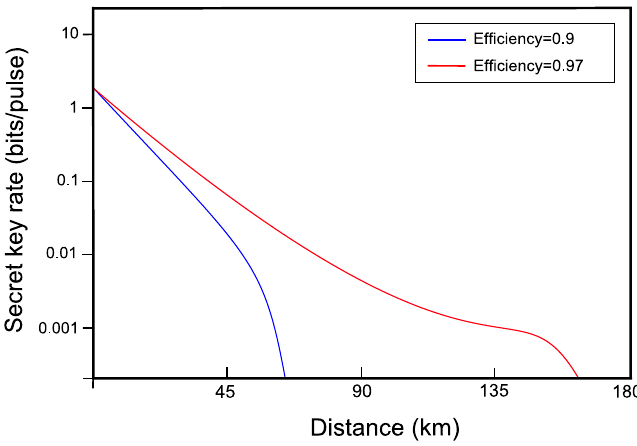
Figure 8. The performance of scalar reconciliation in two-way PM-RR continuous-variable quantum key distribution (CVQKD) at d = 16 (homodyne measurement at both sides). Excess noise: N = 0.015, = 1.06, channel correlation: n = 0.5, signal variance transmittance: T = 0.8, Eve’s variance σ 2 ω C E = σ 2 φ